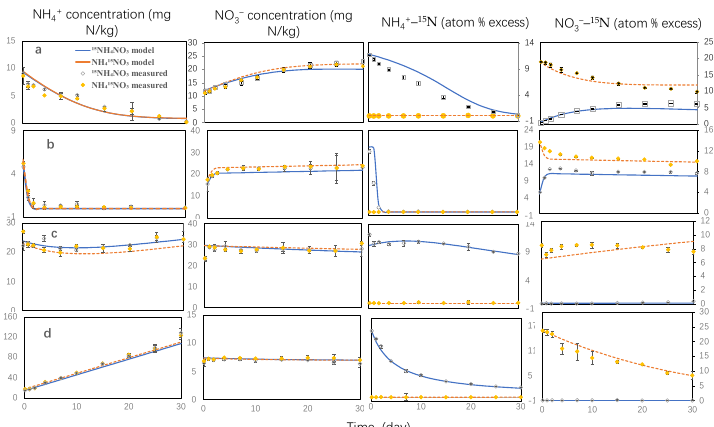
Figure 1. Measured and modeled concentrations of NH 4+ , NO 3 − , and their 15 N enrichment in black soil ( a ), fluvo-aquic soil ( b ), upland red soil ( c ), and paddy red soil ( d ) under aerobic incubation conditions.